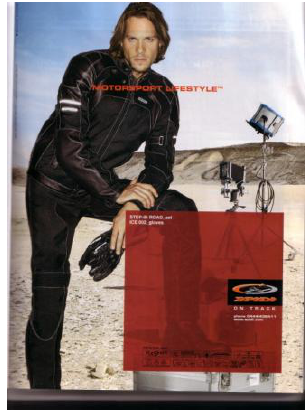
Figure A13. Own selected picture, Fatal man.